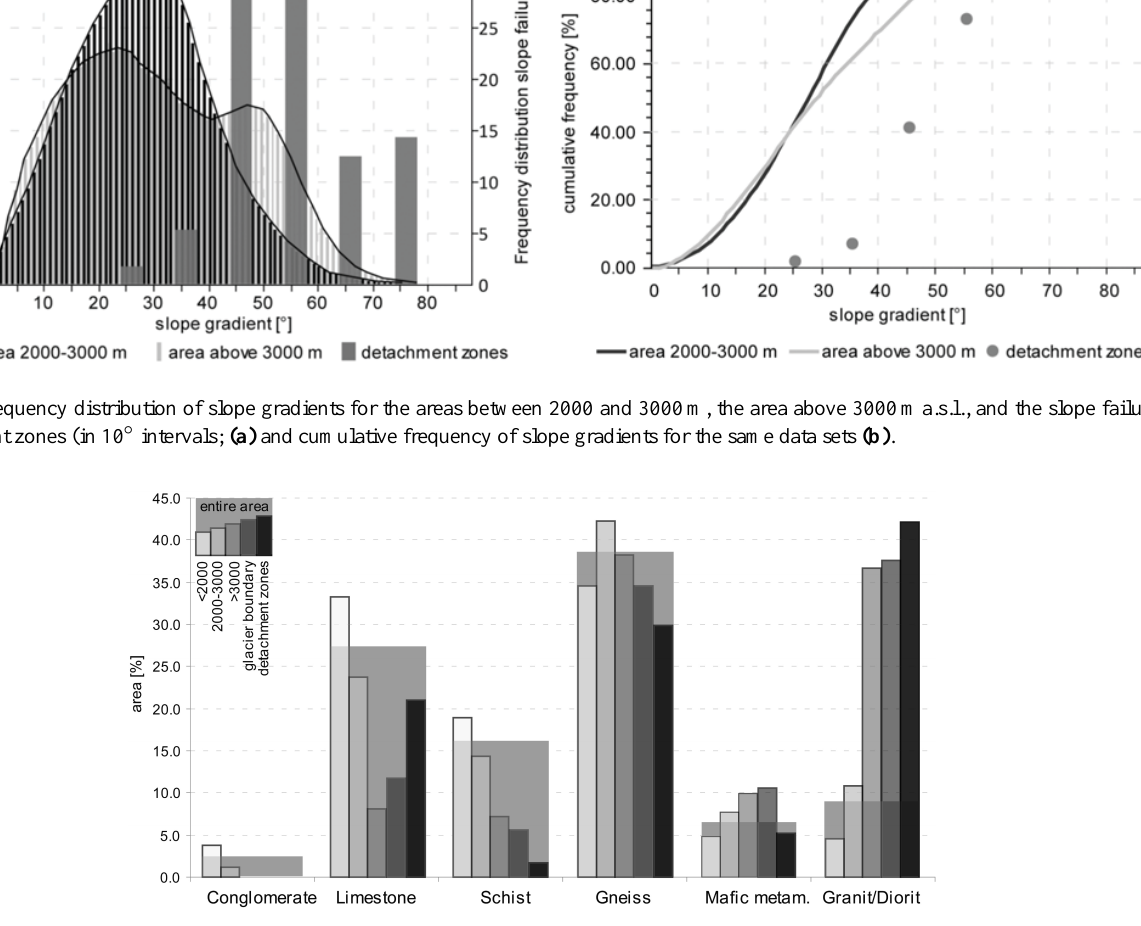
Fig. 8. Area proportion of the different lithological groups in different altitudinal belts, the lithological distribution along the glacier bound- aries, and the lithological setting of the recorded slope failures